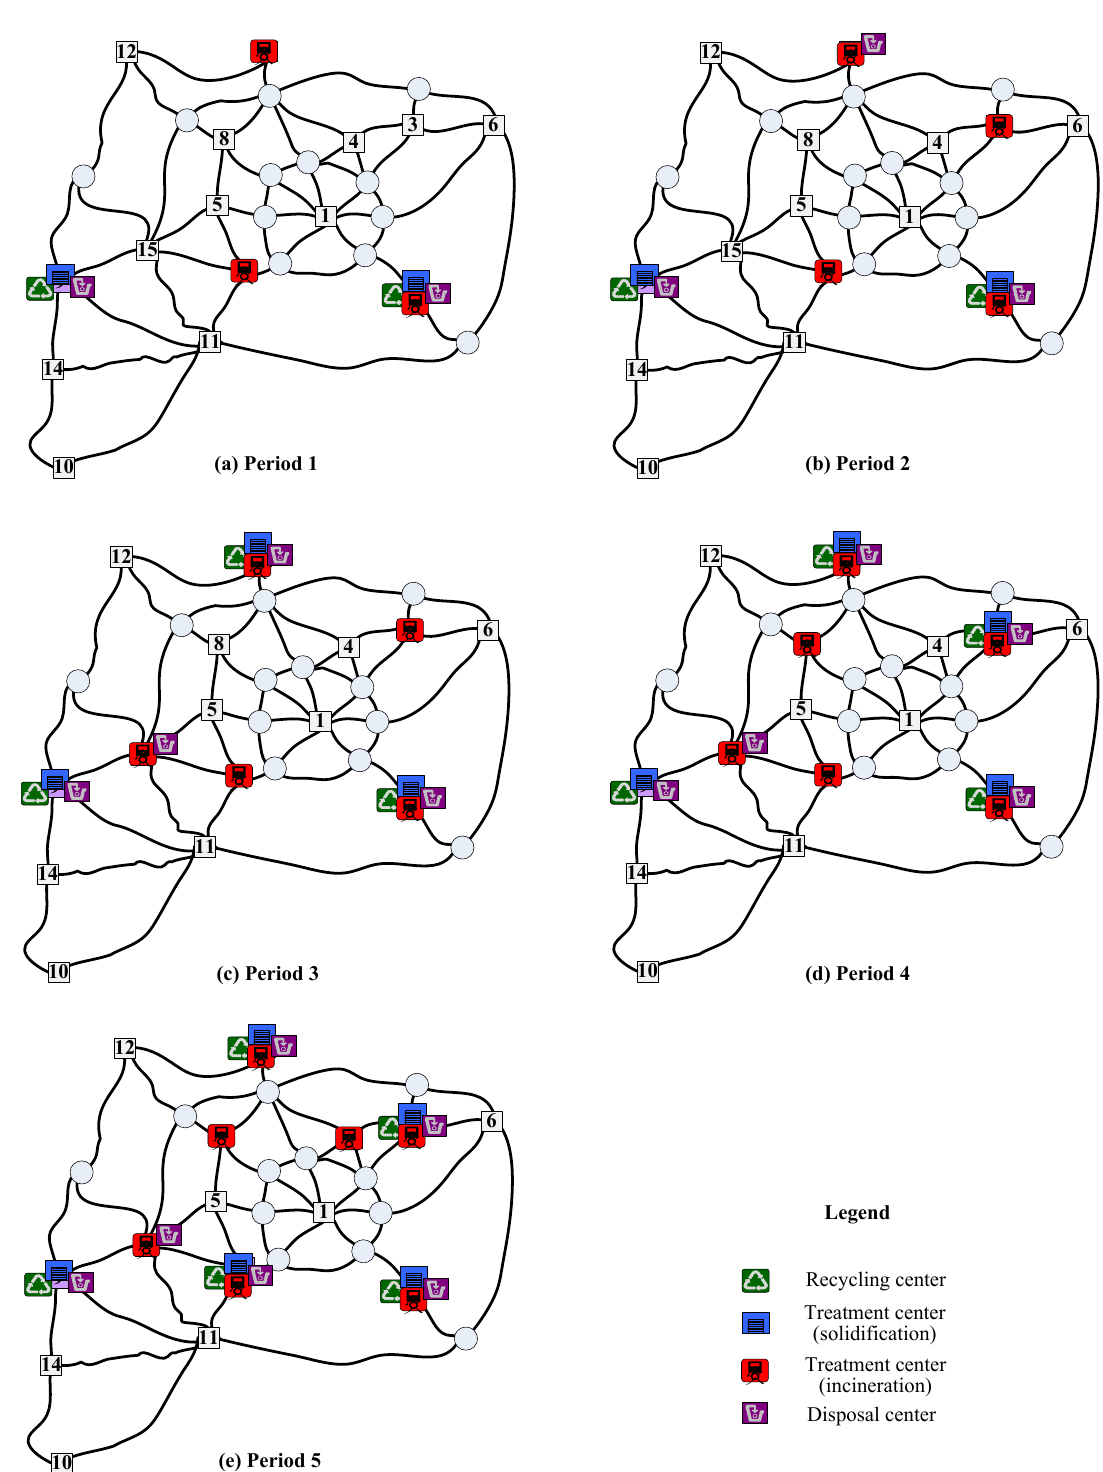
Figure 7. Location in non-dominated solution 2 (balance of two